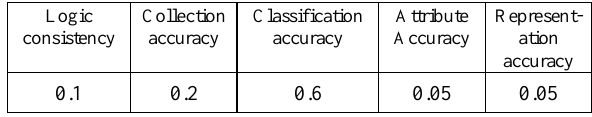
Table 1 Identified factors and weights